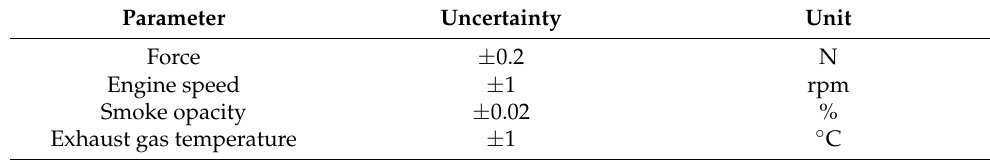
Table 3. Experimental